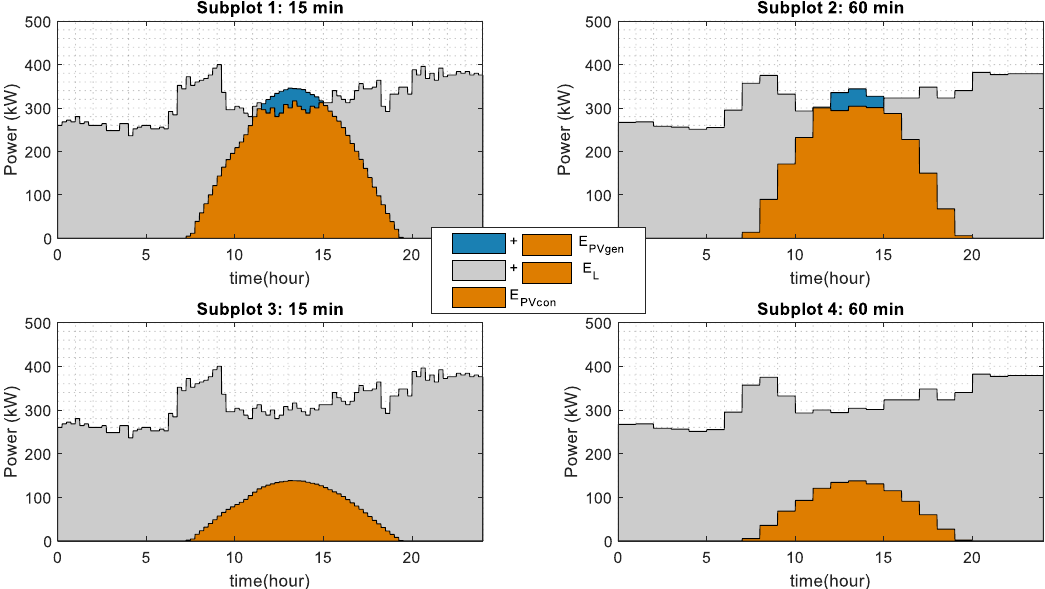
Figure 4. Daily photovoltaic generation and load consumption of an olive mill in Ja é n (South of Spain). Load and Irradiance data correspond to 27 March 2019. E PV,con is represented by the orange area, E PV,gen is given by blue and orange area and E L is represented by grey and orange areas. In Subplots 1 and 2 the array power considered, P 0 , is 500 kW p , meanwhile Subplots 3 and 4 corresponds to array power of 200kW p . The recording interval is 15 min in Subplots 1 and 3; on the other hand, Subplots 2 and 4 has a 60 min recording interval. Orientation angle and tilt angle have a value of 0 ◦